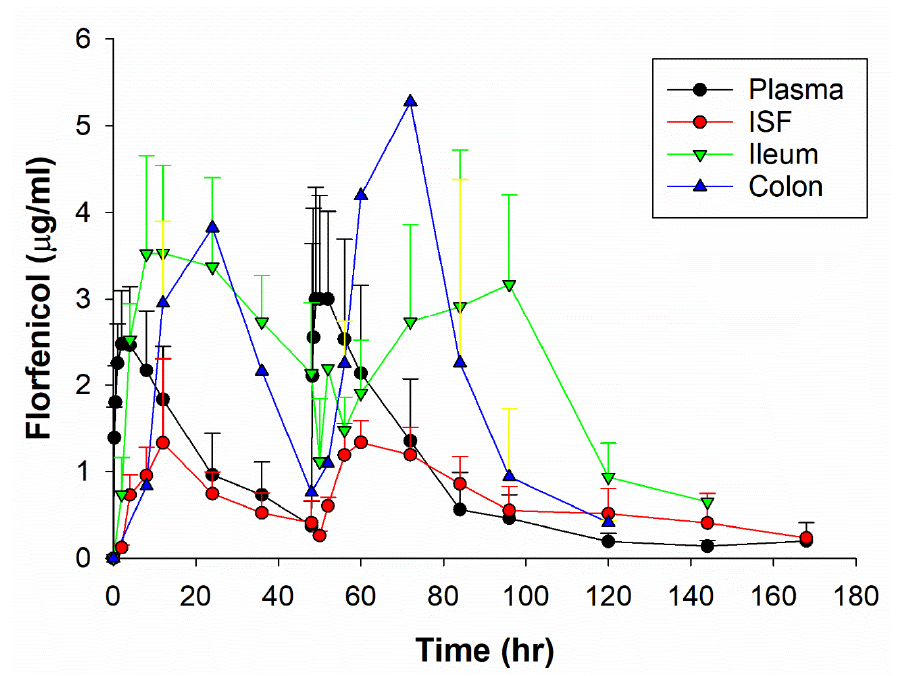
Figure 2. The drug concentration of florfenicol over time for plasma, interstitial fluid, ileum, and colon ultrafiltrate for the steers administered 20 mg/kg of florfenicol intramusculary every 48 h twice. The points represent the means with standard error bars.